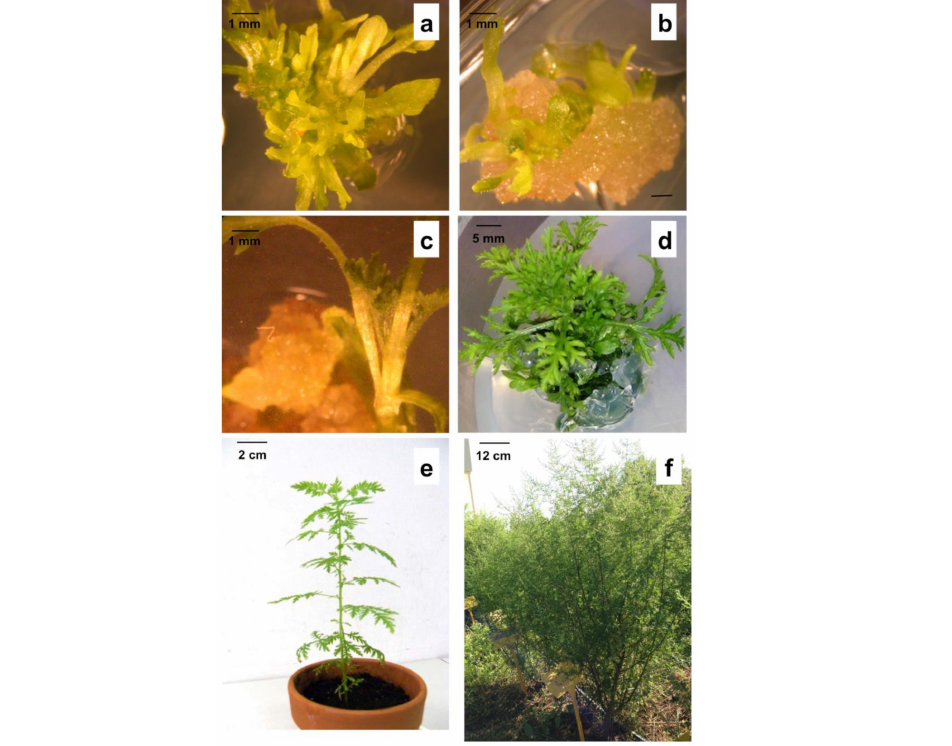
Figure 1. Regeneration process in Artemisia annua L. Shoot regeneration from leaf discs on RM1 ( a ) and RM2 ( b ) after 20 days in dark conditions. ( c ) Shoot elongation from RM1 regeneration after light exposure. ( d ) Microshoots on multiplication medium. ( e ) Regenerated plants (RPs) acclimatized in the greenhouse. ( f ) RPs growing in the